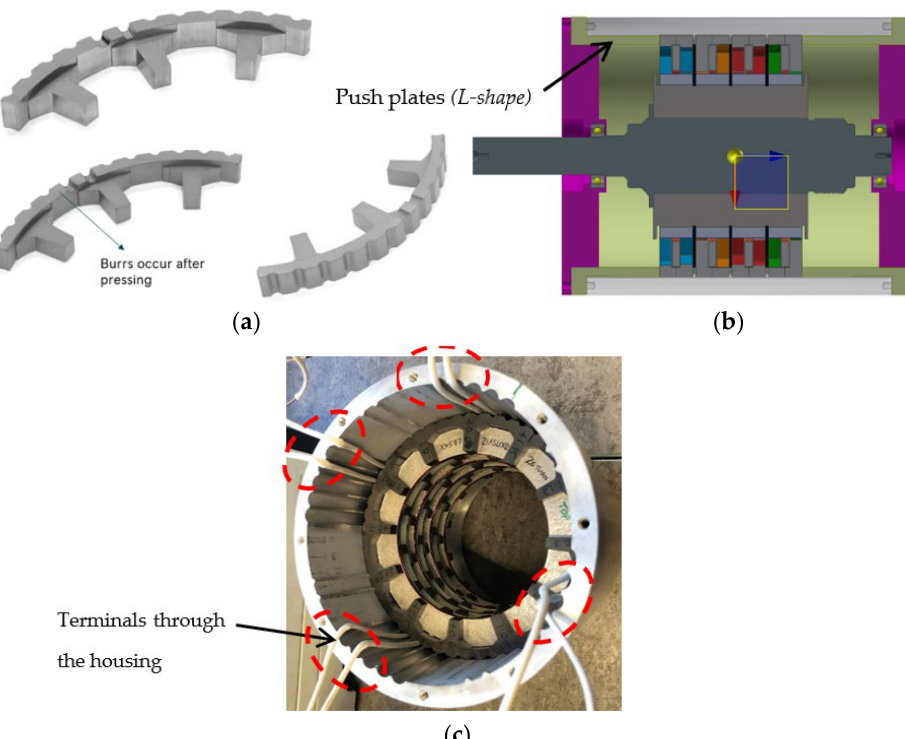
Figure 10. Segmented TFM design with mechanical considerations: ( a ) Compressed Somaloy 130i 5P (by Höganas AB) SMC stator segments, ( b ) L-shape aluminum push plates to ensure that the rotor and stator are axially aligned perfectly, ( c ) aluminum housing locking the stator.